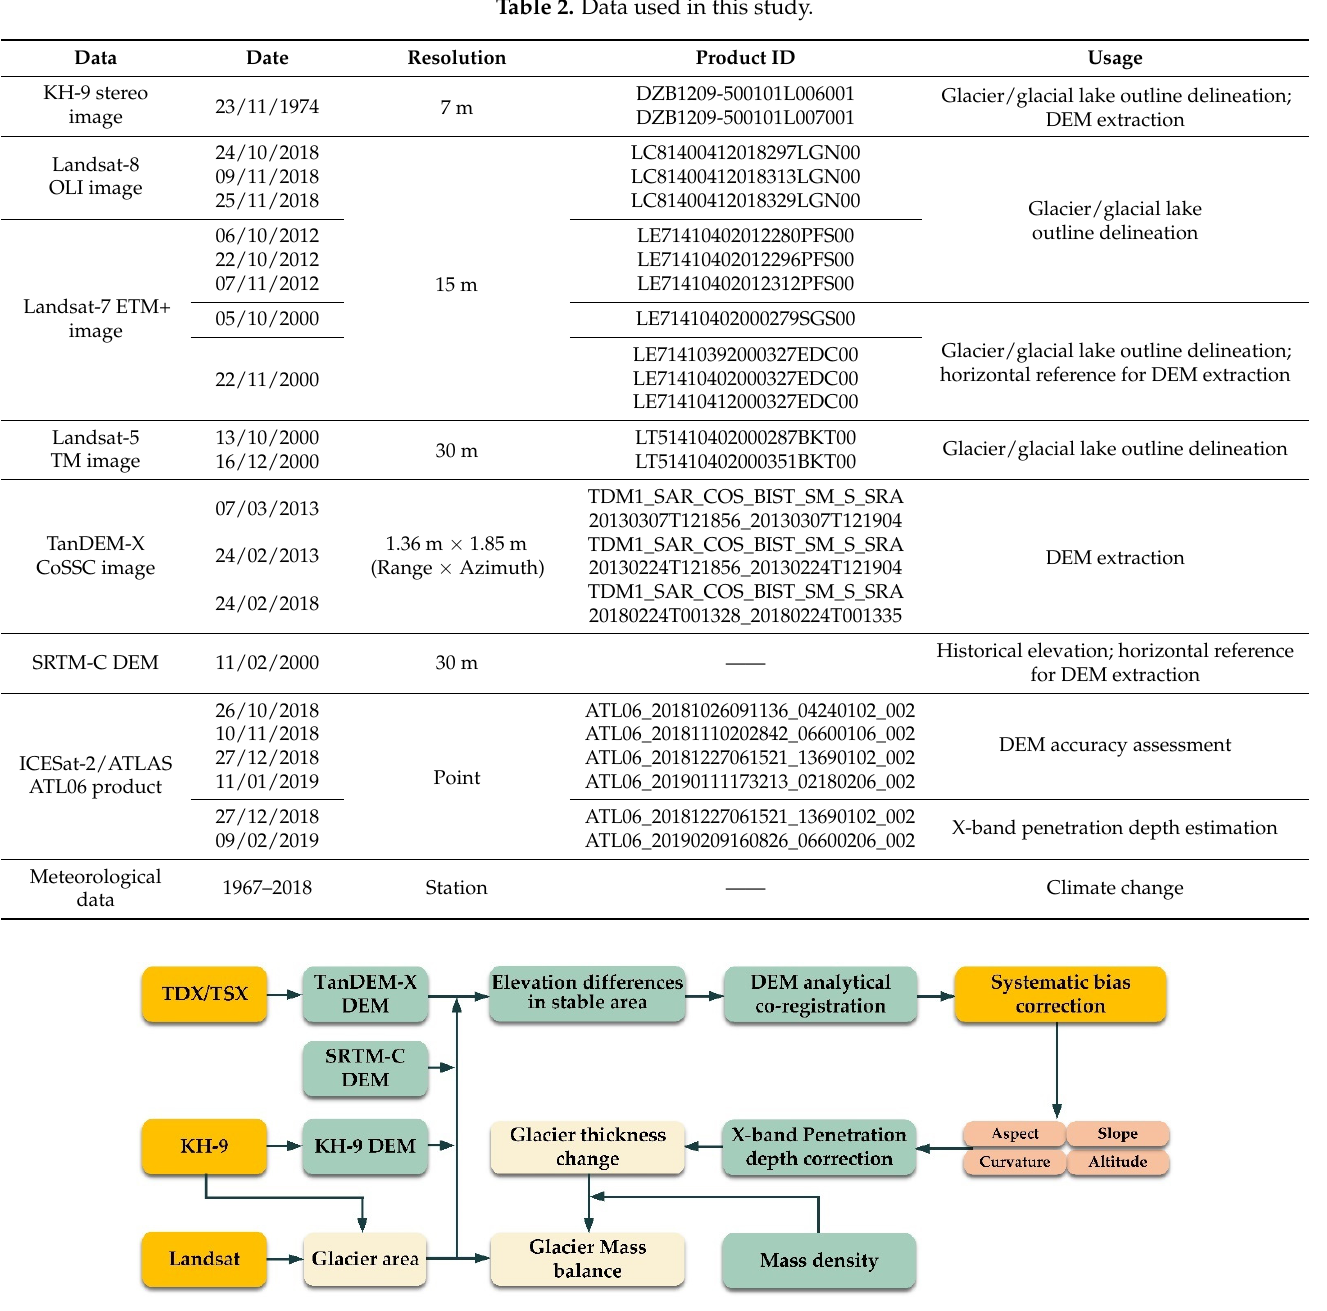
Figure 2. Workflow of glacier mass balance measurement.